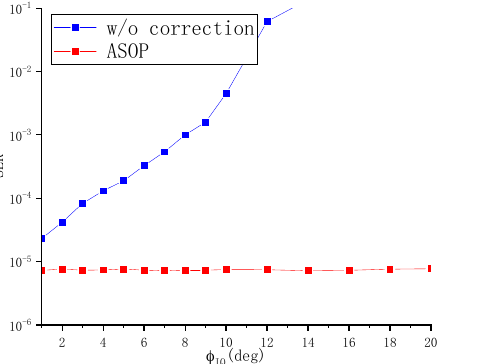
Figure 9. SER versus φ IQ with a carrier frequency offset estimation; W/O: without.